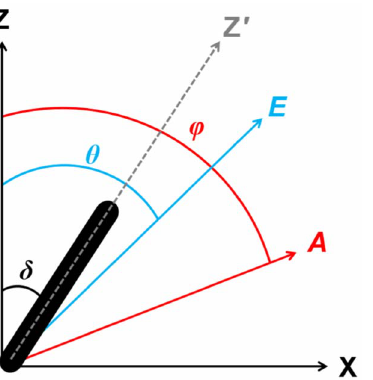
Figure 1. The orientations of coordinate frames in the experiment. The cylindrical axis (Z 9 ) of a crystal (black cylinder) within a cell is oriented in the laser scanning plane (XZ) at an angle, d , away from the laboratory Z-axis. The laser is directed perpendicularly (into the page) with the linear polarization oriented along E , at an angle, h , from the Z-axis. The analyzer is oriented along A , at an angle, Q , from the Z-axis.